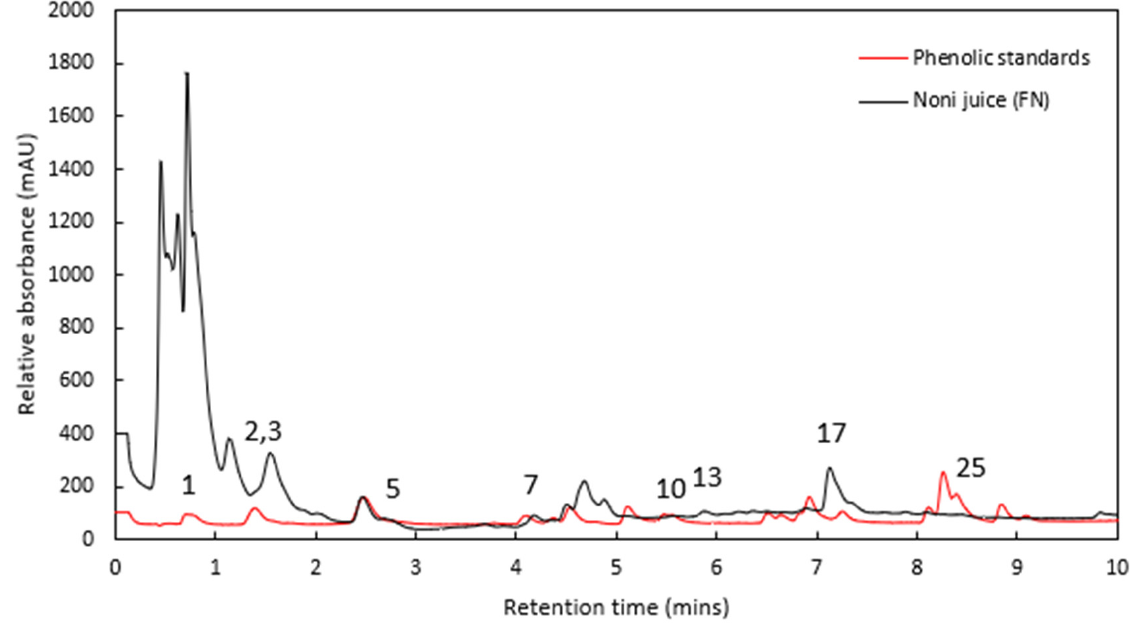
Figure 2. LC-MS chromatogram at 254 nm showing the location of selected phenolic peaks identified in one of the noni juice samples (FN = Fijian Noni). The numbered peaks correspond to the compound numbers in Table